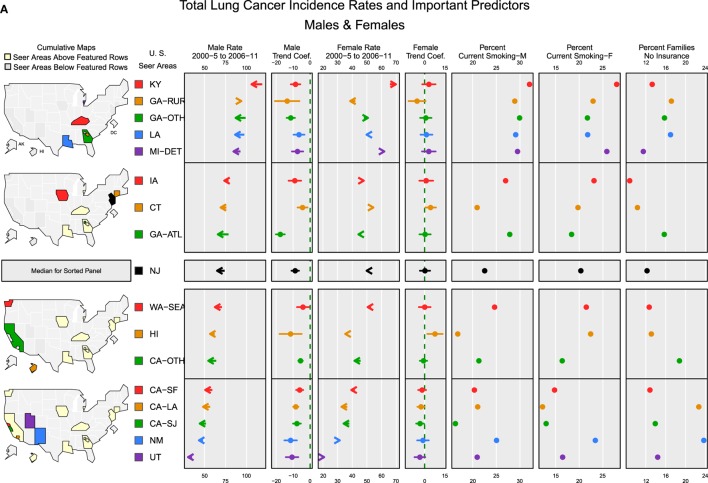
Incidence rates and important predictors for (A) total lung cancer and (B) adenocarcinoma. (A) The covariate values shown are population-weighted averages across counties in each registry. Arrows indicate the direction of change in rates from 2000–2005 (tail) to 2006–2011 (arrowhead). (B) The covariate values shown are population-weighted averages across counties in each registry. Arrows indicate the direction of change in rates from 2000–2005 (tail) to 2006–2011 (arrowhead).